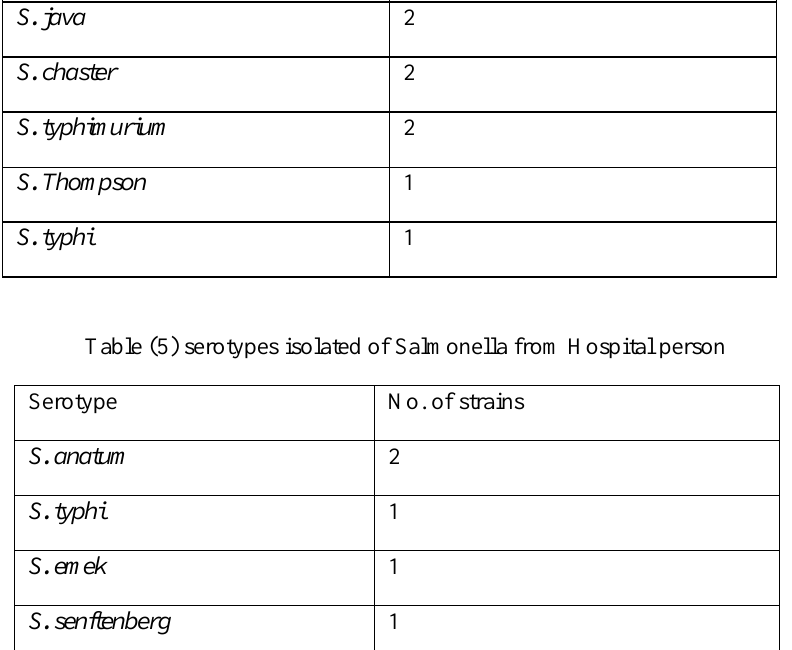
Table( 6)serotypes isolated of Salmonella from employers processing chicken